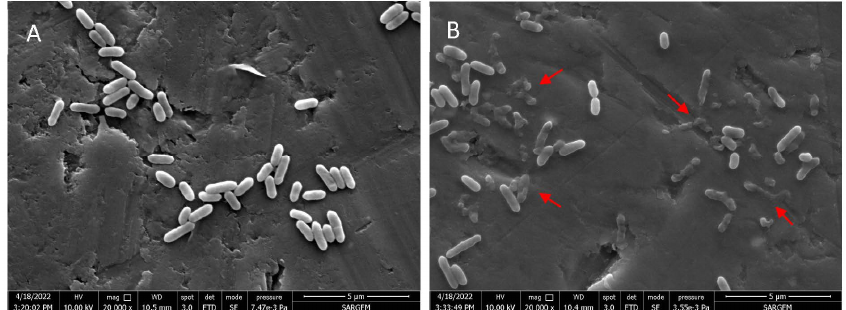
Figure 2. Scanning electron micrographs of cell morphology of L. monocytogenes untreated ( A ), treated with nanoemulsion of myrtle essential oil at MBC for 15 min ( B ).